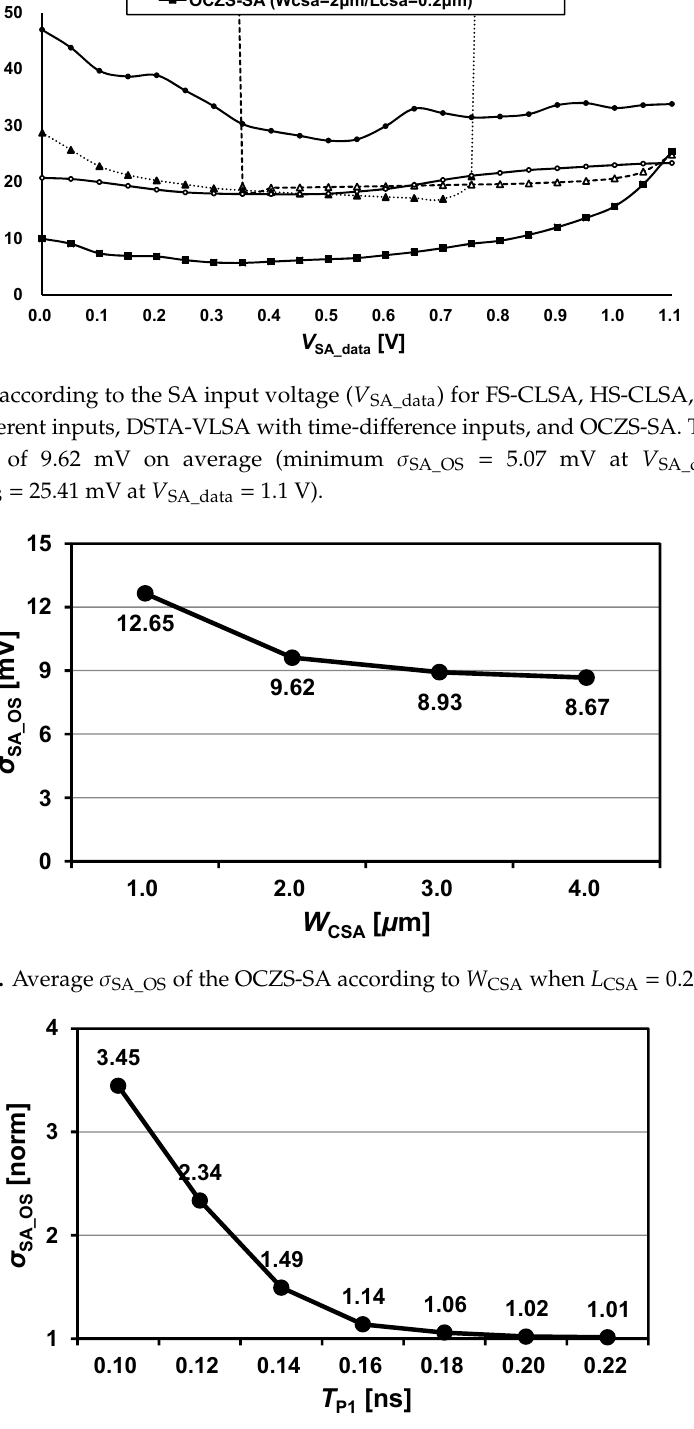
σ SA_OS of the OCZS-SA according to T P1